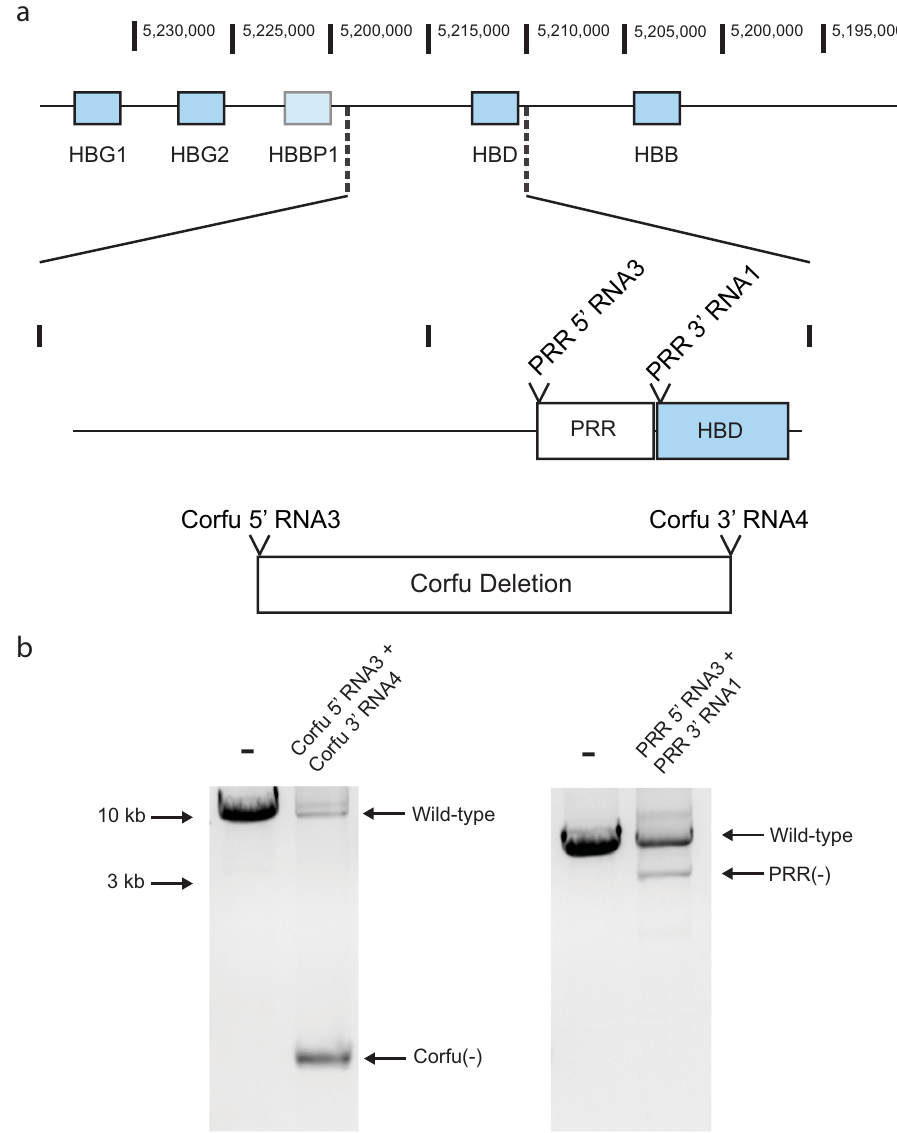
Fig 1. Targeted deletion of genomic regions implicated in γ -globin silencing using selection-free Cas9 RNP electroporation. A) Schematic depicting two targeted regions: the naturally-occurring Corfu HPFH deletion and the 1.7 kb putative repressor region (PRR) upstream of HBD, with the 2 pairs of cuts attempted shown (13) . B) PCR amplification after gene editing with pairs of Cas9 RNPs that delete the Corfu and PRR regions with primers outside the targeted regions. Deletion is indicated by the presence of bands with greater mobility corresponding to the deleted alleles which give rise to shorter PCR products.